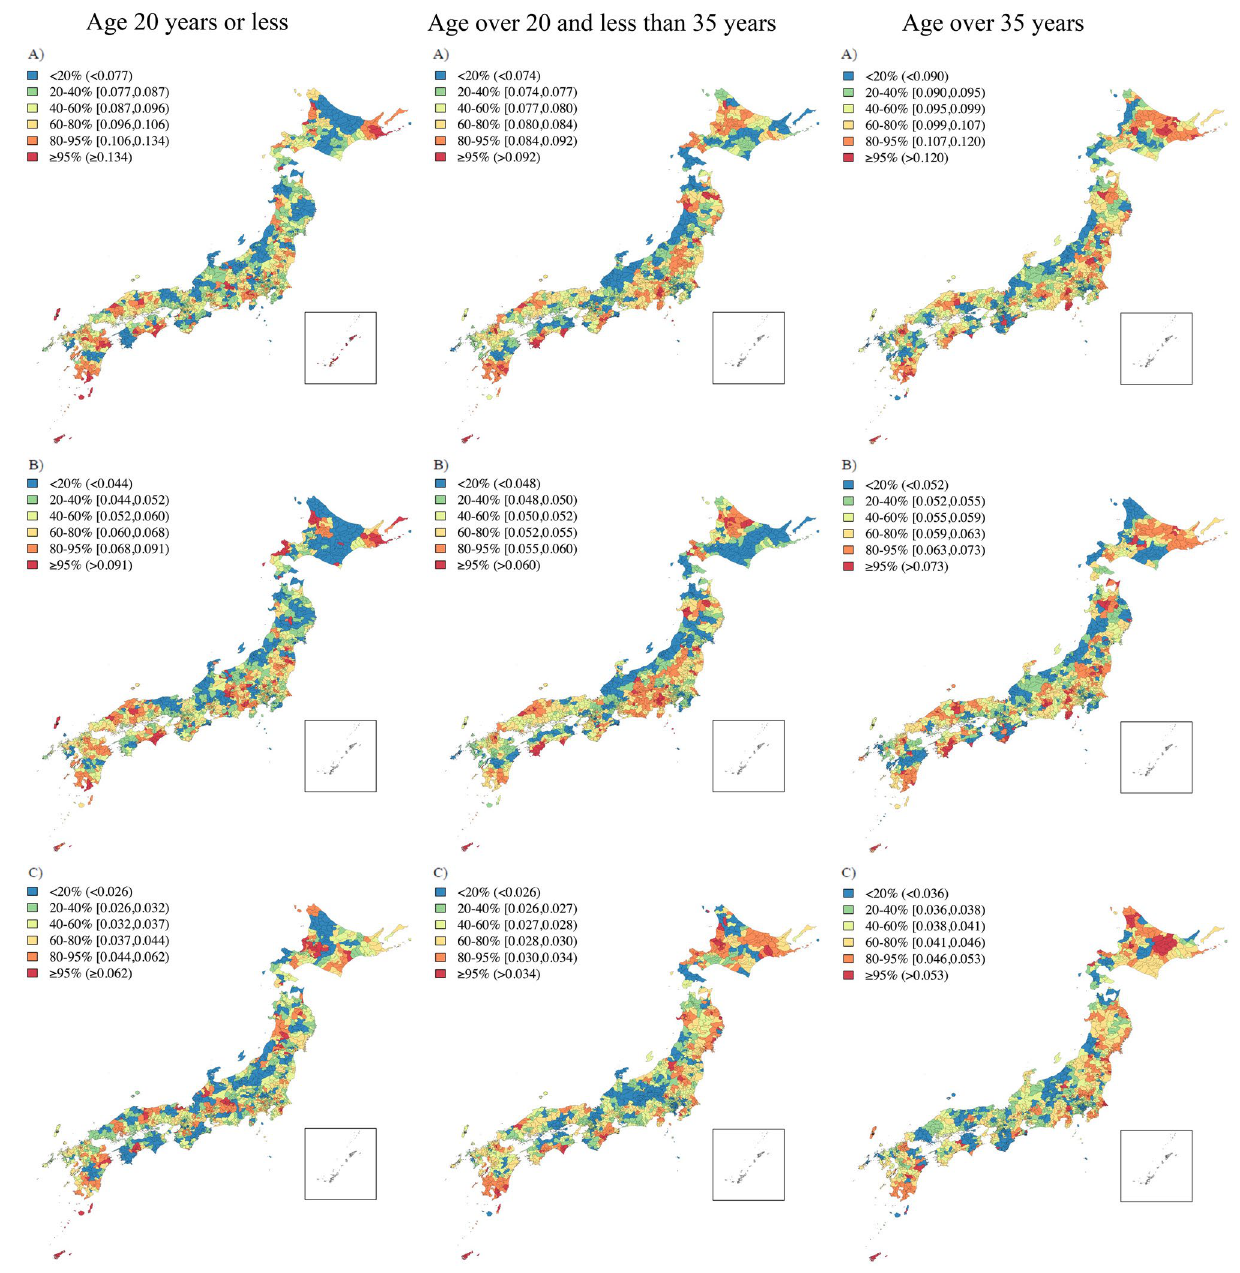
Figure 4. Empirical Bayes estimates of incidence rate of LBW ( A , upper), LBW term ( B , middle) and LBW pre ( C , lower) separately by age groups (20 years or less, 20 and less than 35 years, and over 35 years) in Japan: color scale indicates quantile. This map was created using R version 3.6.1 (https:// cran.r- proje ct. org/) and zipangu